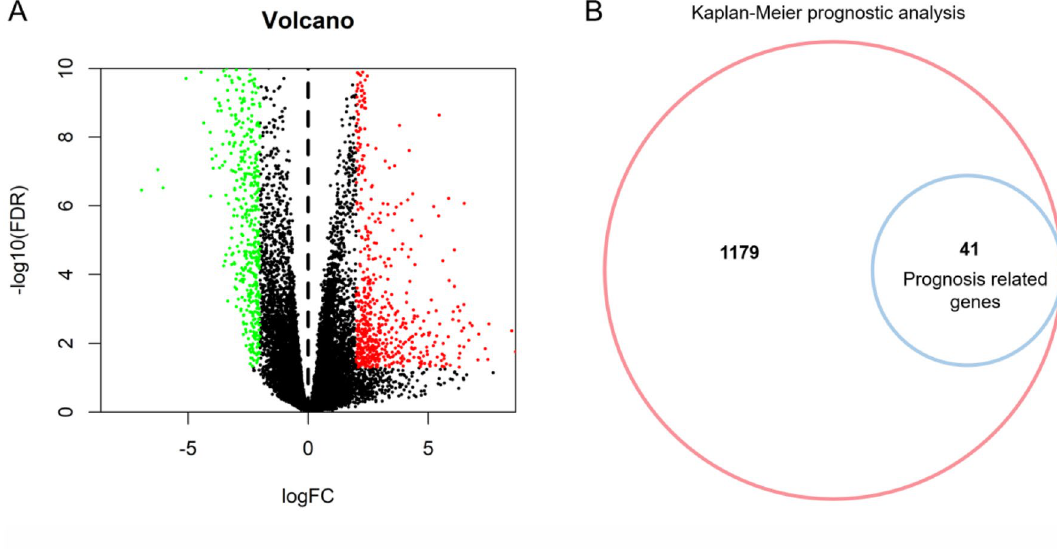
Figure 1. Differential gene analysis and prognosis analysis of esophageal cancer. ( A ) 1220 DEGs differentially expressed between the EC and adjacent tissues. Red dots represent differentially expressed up-regulated genes, green dots represent differentially expressed down-regulated genes, and black dots represent no significant difference in gene expression. ( B ) Kaplan–Meier (KM) prognostic analysis of DEGs. 41 genes of 1220 genes in the DEGs were associated with the prognosis of patients with esophageal